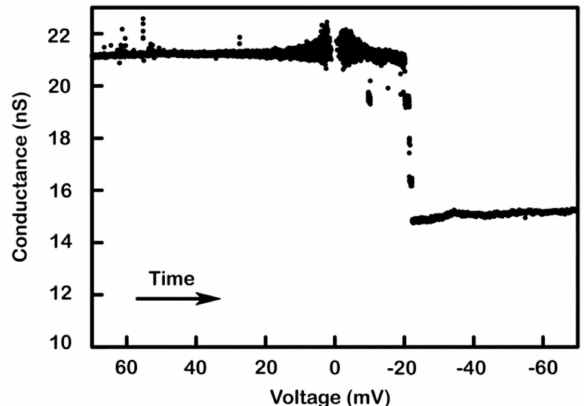
Figure 10. Supportive evidence of the model: multi-triplin containing membranes. A 2 mHz (0.28 mV / s) triangular voltage ramp ( ± 70 mV) was applied to a membrane. In the illustrated segment the voltage changed from positive to negative values and at − 20 mV, four decrements are visible indicating the closure of four channel 2s. Of the remaining conductance, only 6 nS could be due to the remain channel 3s of the active triplins. The remaining nine nS (total of 15 nS) are consistent with the two non-gating triplins. Therefore, at positive voltages the conductance was composed of two non-gating triplins and four gating triplins i.e. with their channel 1s closed (3.0 nS per triplin) for a total of 21